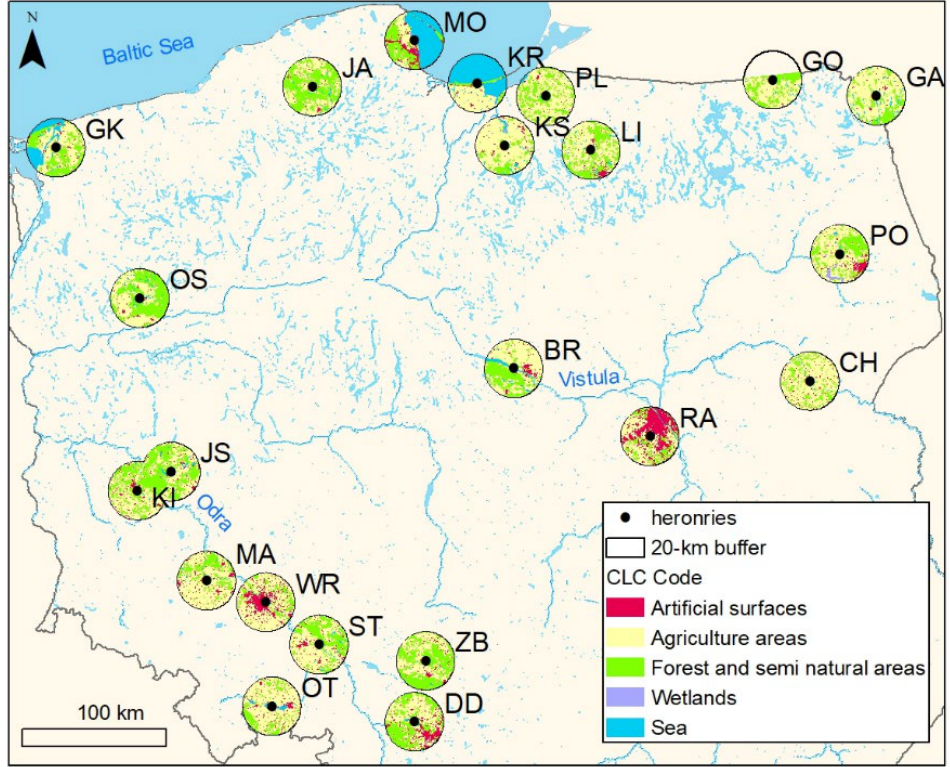
Figure 1. Study area showing locations of the investigated grey heron colonies and main habitat types according to the Corine Land Cover CLC2012 model, level 1; (https://land.copernicus.eu/pan- european/corine-land-cover/clc-2012 (accessed on 1 February 2022)) in 20 km buffers around the colonies representing potential foraging